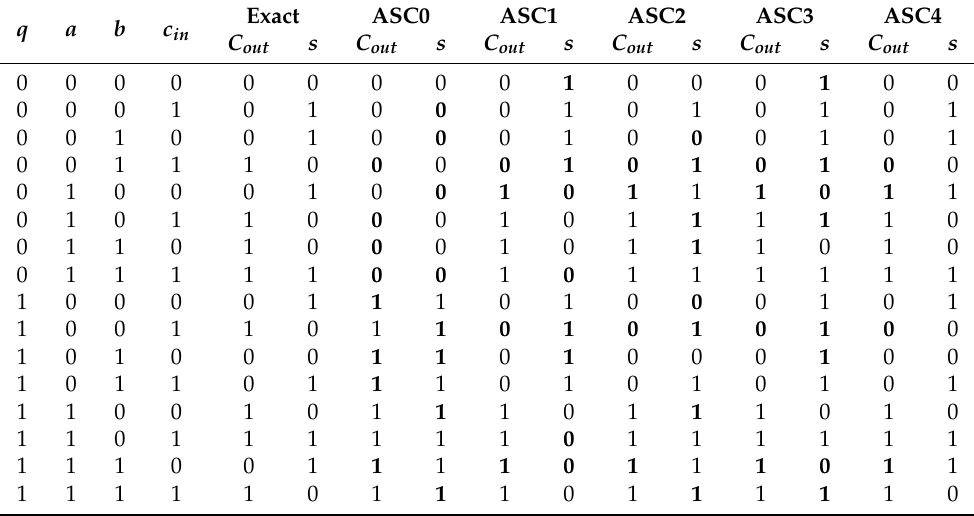
Figure 3. Approximate Controlled Add–Subtract (CAS) cells: ( a ) ASC0, ( b ) ASC1, ( c ) ASC2, ( d ) ASC3, and ( e ) ASC4. Table 1. Truth table for CAS designs ( bold numbers show incorrect